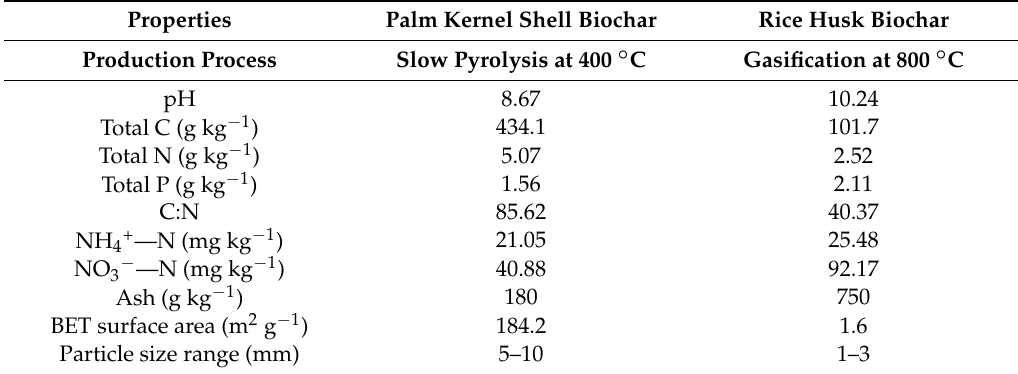
Table 1. Selected properties of pyrolytic palm kernel and gasified rice husk biochar used in this study